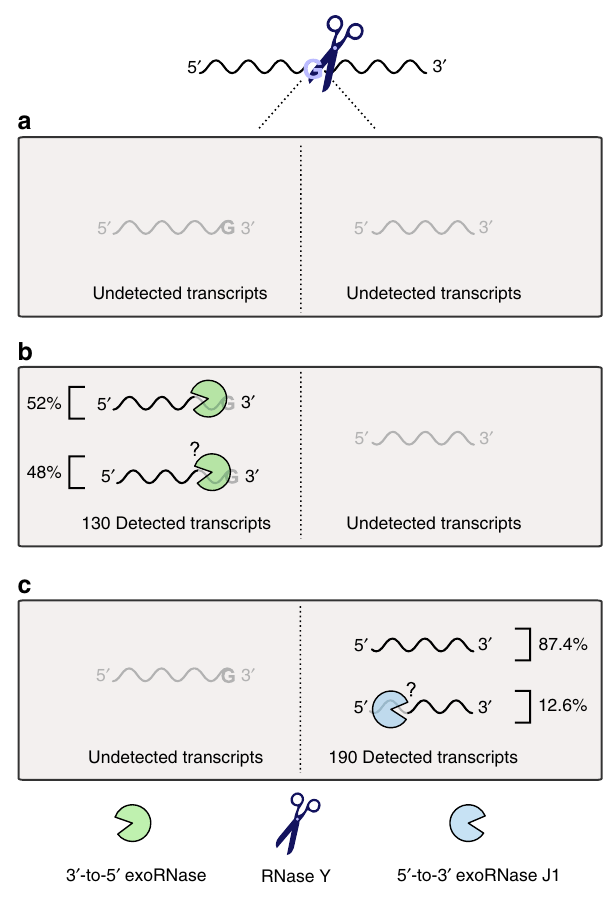
Fig. 10 Fate of the RNAs cleaved by RNase Y in S. pyogenes . RNase Y processing occurs preferentially after a G. The two processing products generated from the same molecule were never detected